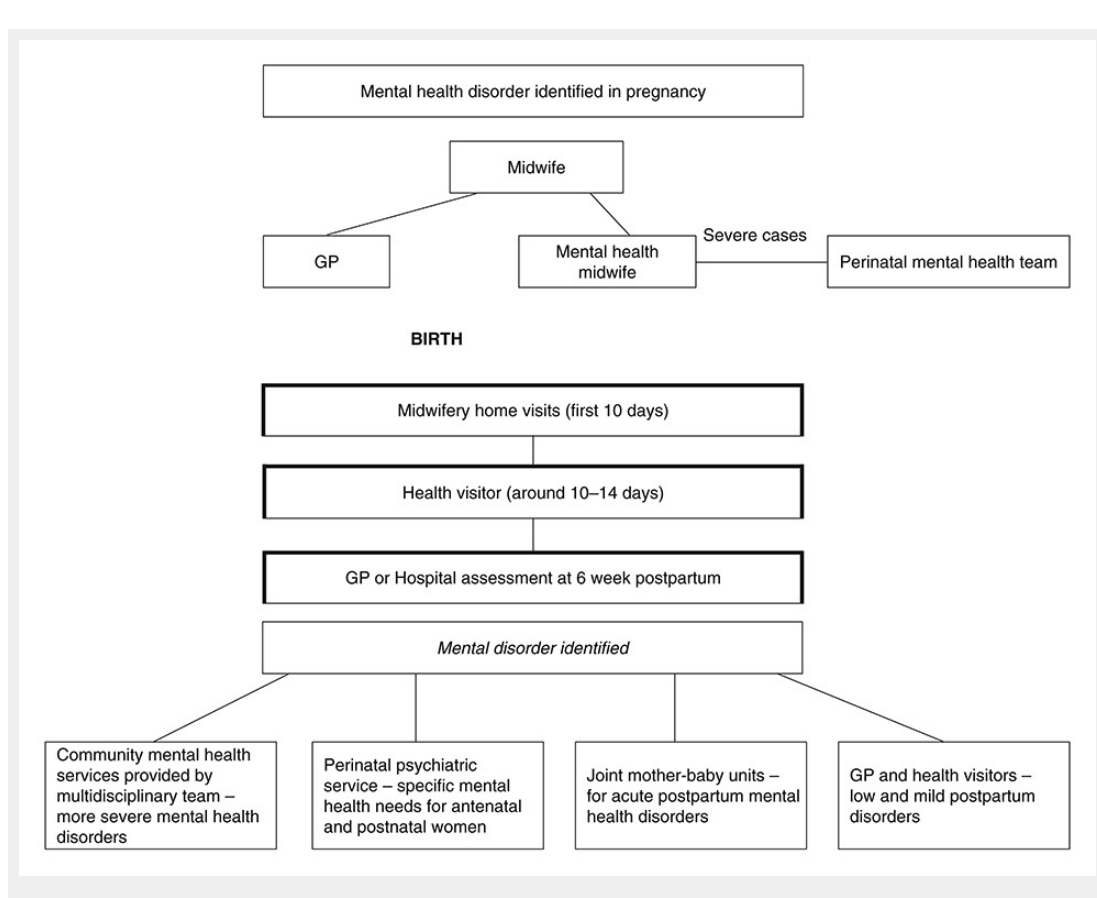
Figure 1 Care pathways offered to perinatal women with mental disorders in the